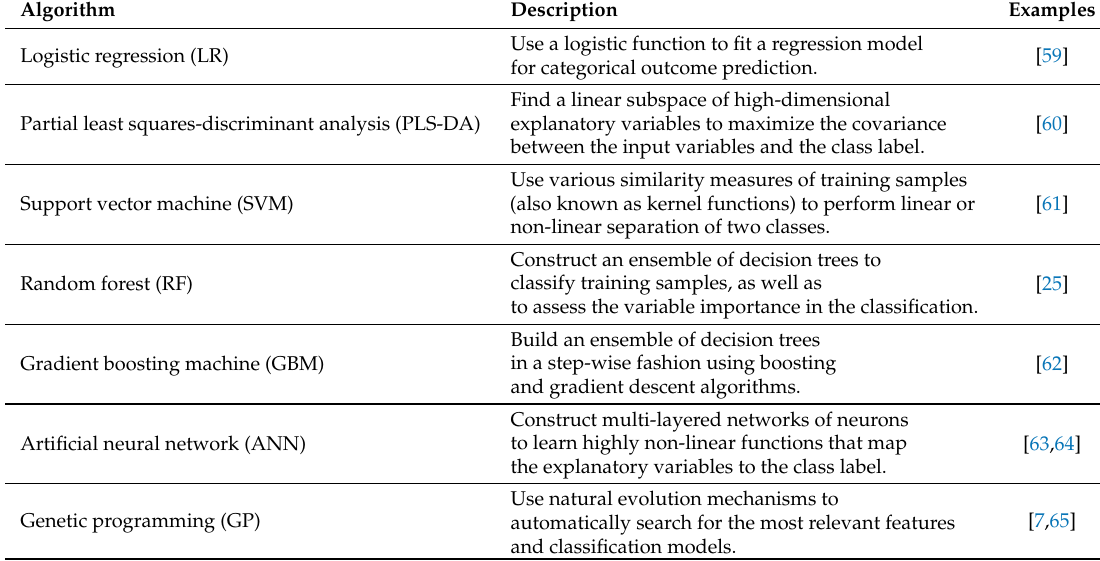
Table 1. Machine-learning algorithms and their example applications to metabolic marker discovery.